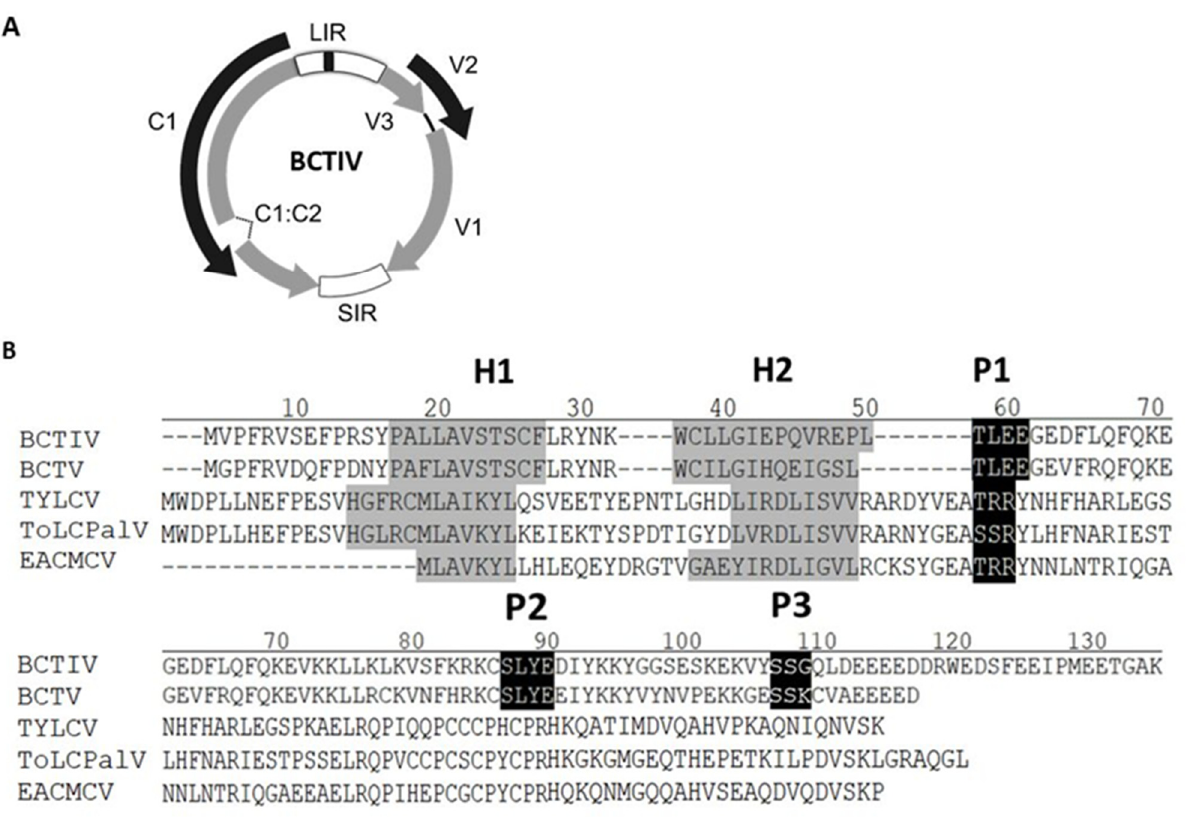
Figure 1. ( A ): Beet curly top Iran virus (BCTIV) genome structure. Arrows represent open reading frames (ORFs). LIR: long intergenic region; SIR: short intergenic region. Common region inside LIR is depicted in black ( B ): Alignment of the aminoacid sequences of the V2 proteins from the becurtovirus beet curly top Iran virus (BCTIV; AFK14083), the curtovirus beet curly top virus (BCTV; AAA42752.1), the begomoviruses tomato yellow leaf curl virus (TYLCV; CAA33687.1), tomato leaf curl Palampur virus (ToLCPalV; CAP03292), and East African cassava mosaic Cameron virus (EACMCV; AF112354). Gaps (-) were introduced to optimize the alignment. The positions of the predicted putative phosphorylation motifs P1 (protein kinase CK2/protein kinase C), P2 (protein kinase CK2), and P3 (protein kinase C) are depicted in white letters inside black boxes. The hydrophobic domains (H1 and H2) are shadowed in